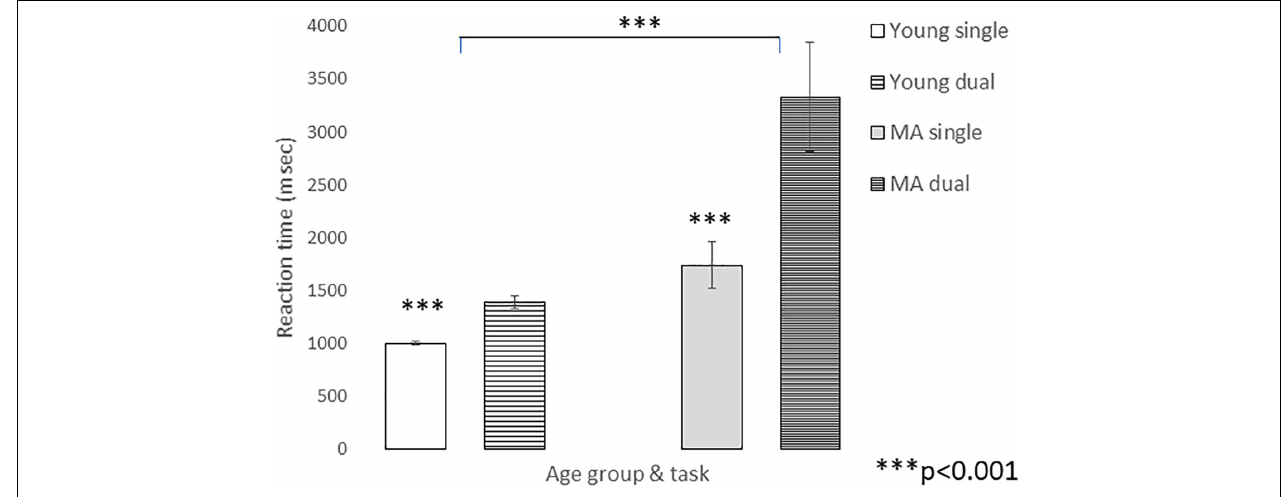
FIGURE 4 | Mean ( ± se) of visual reaction time in the single (solid) and dual (pattern) tasks for Young (white) and MA (gray)